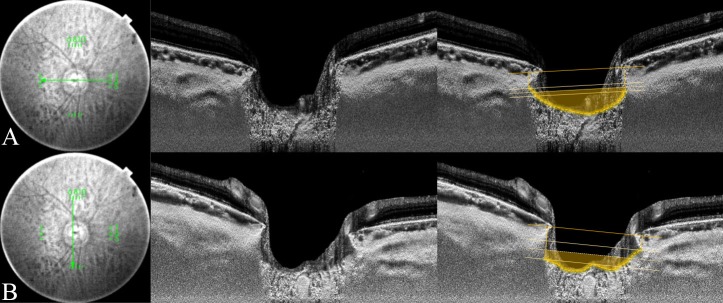
Measurement of lamina cribrosa (LC) curvature index in primary open-angle glaucoma eye.The horizontal and vertical optic disc scans of a 70-year-old patient with primary open-angle glaucoma (POAG). The image delineated with yellow guidelines is the same as that depicted on the left side. The horizontal and vertical mean anterior laminar insertion depth (ALID) was 304.6 μm and 274.1 μm, respectively. The horizontal and vertical mean LC depth was 404.9 μm and 366.4 μm, respectively. The horizontal LC curvature index was 100.3 μm and the vertical LC curvature index was 92.3 μm. The yellow-shaded area exhibits the degree of the posteriorly located anterior LC surface according to the mean level of the anterior laminar insertion (ALI).